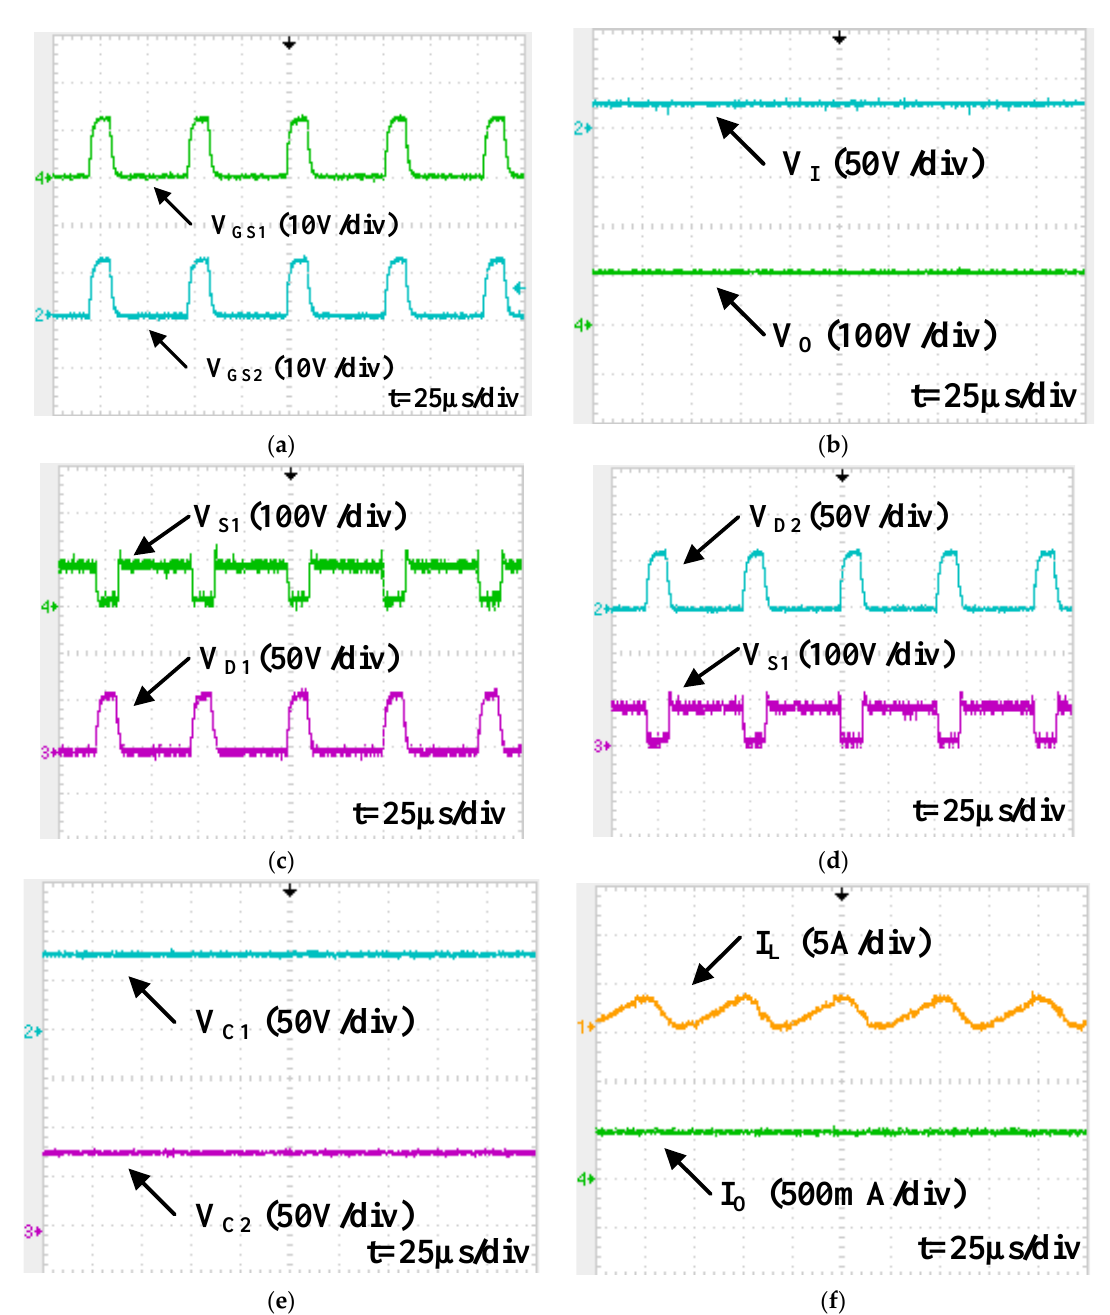
Figure 18. ( a ) Gate signals for both MOSFETs S 1 and S 2 , ( b ) input and output voltages, ( c ) voltages across switch S 1 and diode D 1 , ( d ) voltages across switch S 2 and diode D 2 , ( e ) voltages across both capacitors C 1 and C 2 , and ( f ) inductor current and output current.